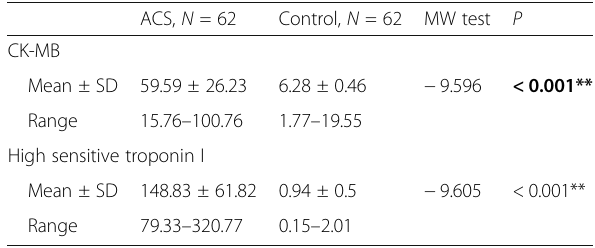
Table 2 A statistical analysis of CK-MB and high sensitive troponin I levels in the studied groups